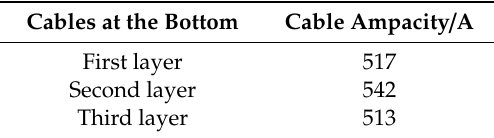
Figure 9. Photos on site and temperature field distribution with 517 A current. ( a ) Photos of cables irregularly laid on site. ( b ) Temperature field distribution (Unit: K). Table 4. Cable ampacity when di ff erent layers are laid at the